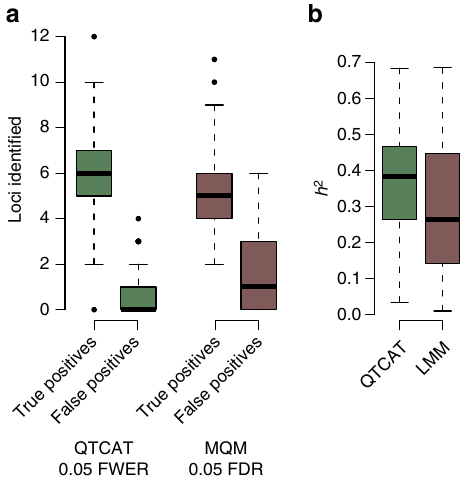
Figure 4 | Linkage mapping results based on simulated biparental populations. ( a ) Differences in the number of true and false positive loci identified by QTCAT and MQM ( P -value ¼ 0.006721, Wilcoxon test). ( b ) Differences in the explained variances of the loci identified by QTCAT and MQM ( P -value ¼ 0.01336, Wilcoxon test). Boxplots show median (bold line), the first to third quartile (box) and whiskers showing span of remaining data (max. 1.5 times of the box size). QTCAT identified significantly more causal loci (on average 5.98 versus 5.35, P -value ¼ 0.006721, Wilcoxon test) and significantly less false positives (0.71 versus 1.62, P -value ¼ 5.033 e (cid:3) 07, Wilcoxon test; Fig. 4a). The results of QTCAT and MQM explained on average 0.36 and 0.31 of the variance ( P -value ¼ 0.01336, Wilcoxon test; Fig. 4b). Though biparental populations have no population structure and an allele frequency of B 0.5, they comprise extended regions with strong linkage due to the low number of recombination events introduced during their generation. These long haplotypes can lead to ‘ghost quantitative trait loci (QTLs)’ 28 , which occur in between two causal linked loci as the low resolution hampers the separation of both signals. Across all 100 simulations we found 17 ‘ghost QTLs’ predicted by MQM. In all cases, QTCAT did not report the ‘ghost QTL’ but either one or both of the neighbouring causal loci.